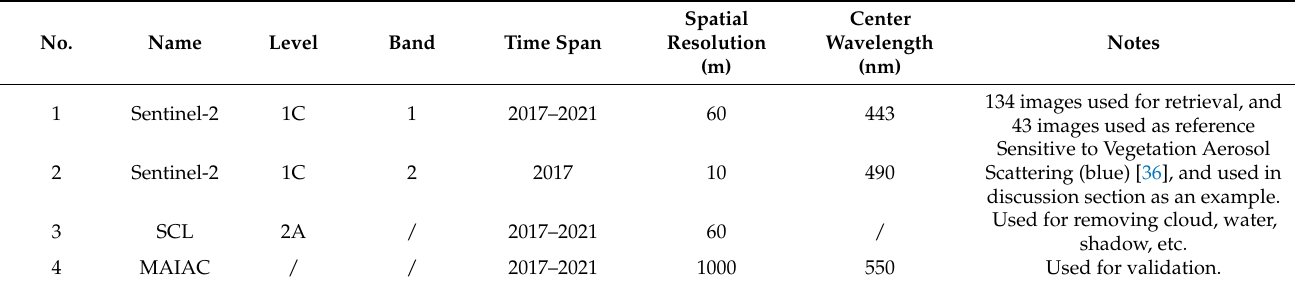
Table 2. Summary of the satellite images and products used in this